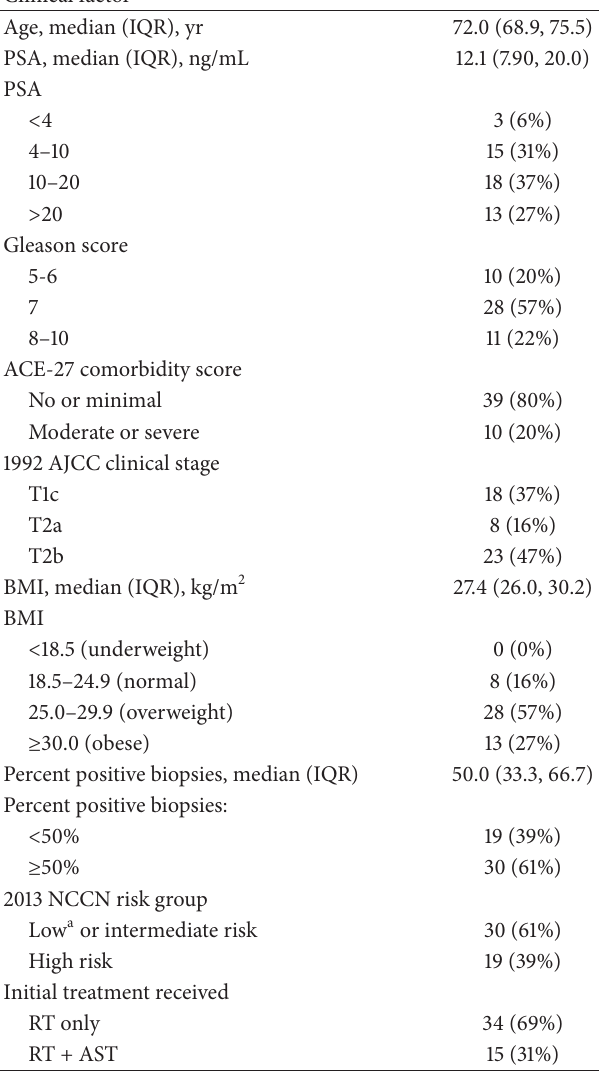
Table 1: Description of the 49 men in the study cohort who underwent sAST stratified by clinical factors at randomization and initial treatment.